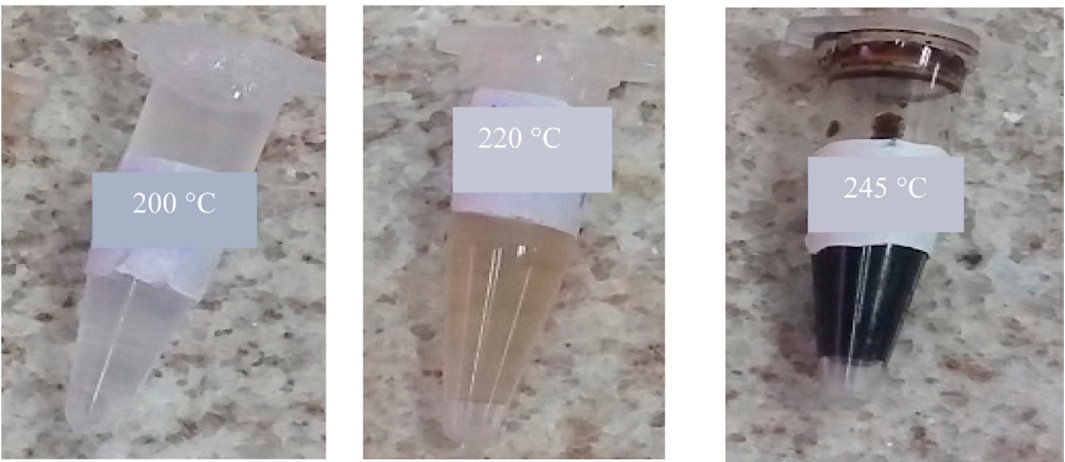
Figure 9. Effect of temperature on the transparency of the product of glycerol polymerization in the presence of calcined eggshell (CaO) (reprinted from [3], copyright 2020, Elsevier).